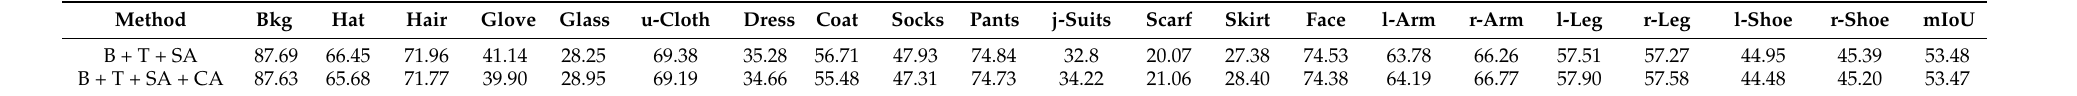
Table 6. Comparison of different components in DFE